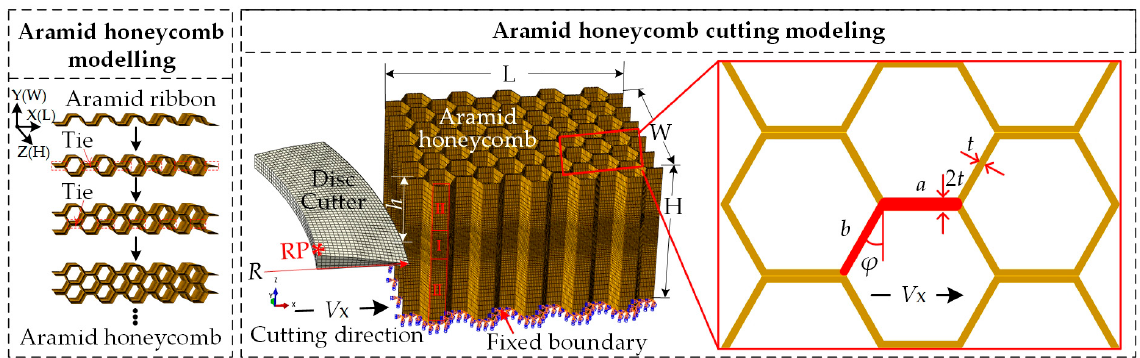
Figure 1. Finite element modelling of the aramid honeycomb cutting process.